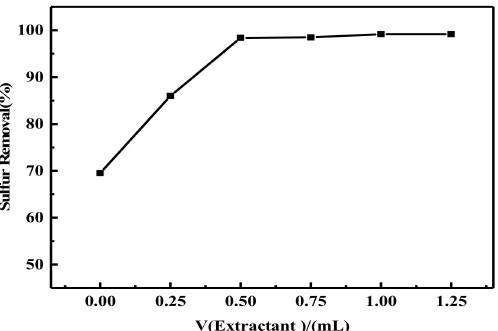
Figure 8. Effect of extractant dosage on desulfurization efficiency. Reaction conditions: V(oil) = 5 mL; n(catalyst)/n(S) = 0.025; n(H 2 O 2 )/n(S) = 6; t = 60 min; T = 50 ◦